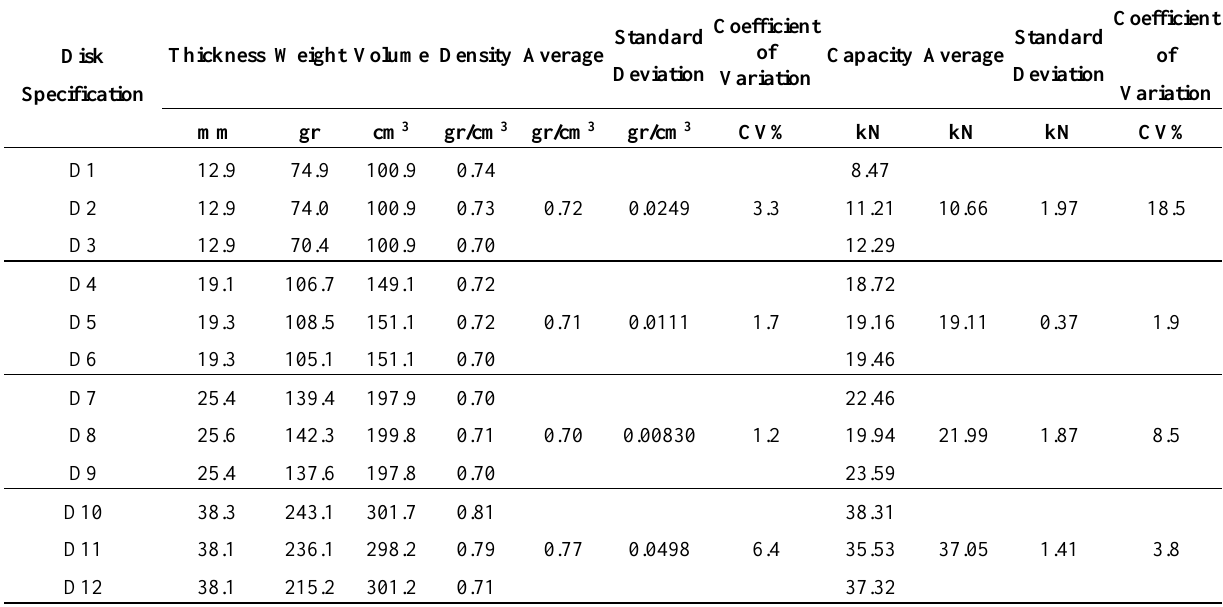
Table 2. Lumber disk puncture test results.